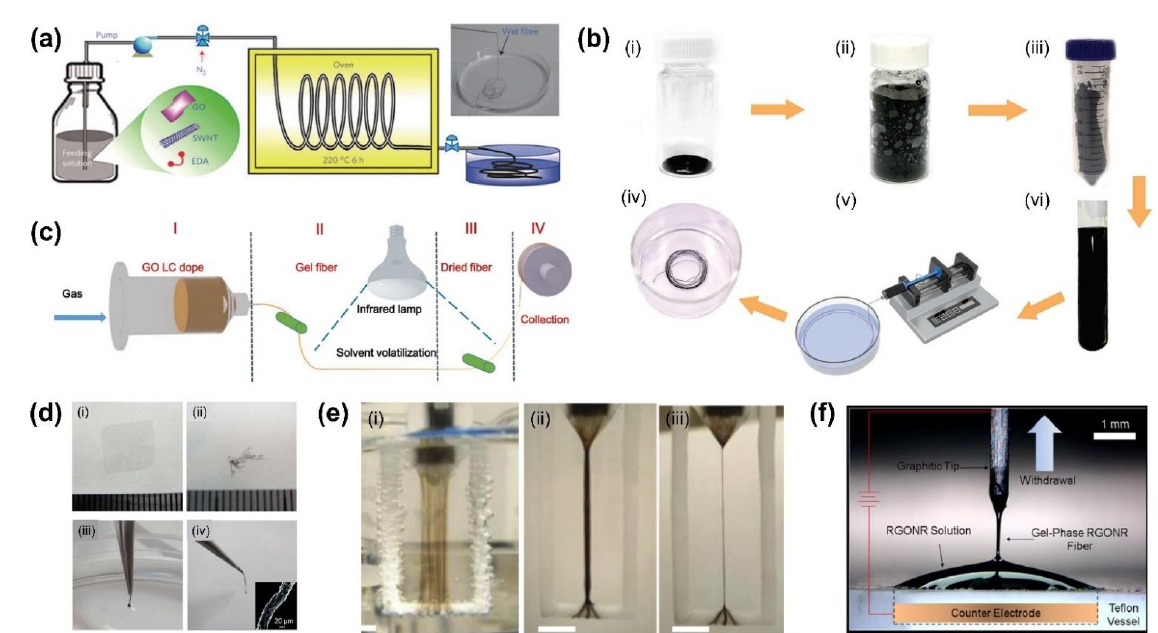
Figure 2. ( a ) Schematic of the hydrothermal fabrication procedures of CNT/graphene fibers [78] (copyright permission Nature Publishing Group 2014); ( b ) Schematic illustration of the fabrication of the wet-spun CNT/graphene hybrid fiber [57] (copyright permission Wiley-VCH 2017); ( c ) Schematic illustration of the dry spinning process with a concentrated organic dispersion of GO [79] (copyright permission The Royal Society of Chemistry 2017); ( d ) CVD graphene film to fiber self-assembly [80] (copyright permission American Chemical Society 2011);( e ) Illustration of the sequential step process of graphene nanoribbon yarn fabrication [81] (copyright permission Wiley-VCH 2012); ( f ) Photograph of a reduced graphene oxide nanoribbon fiber formed by the electrophoretic self-assembly method [82] (copyright permission IOP Publishing 2012).